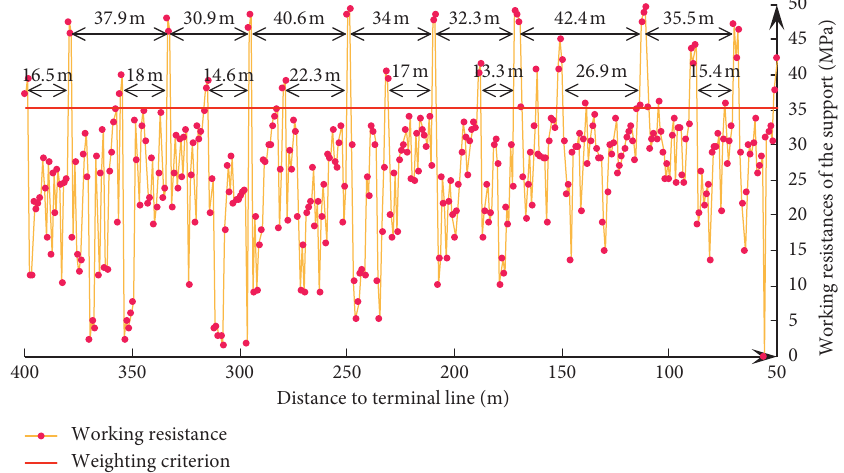
Figure 10: Working resistance curve of the support during the mining of the #2 coal seam.